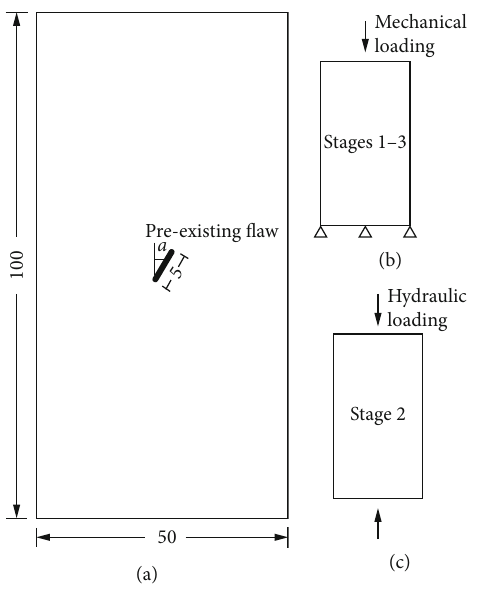
Figure 1: Designed rock sample and loading